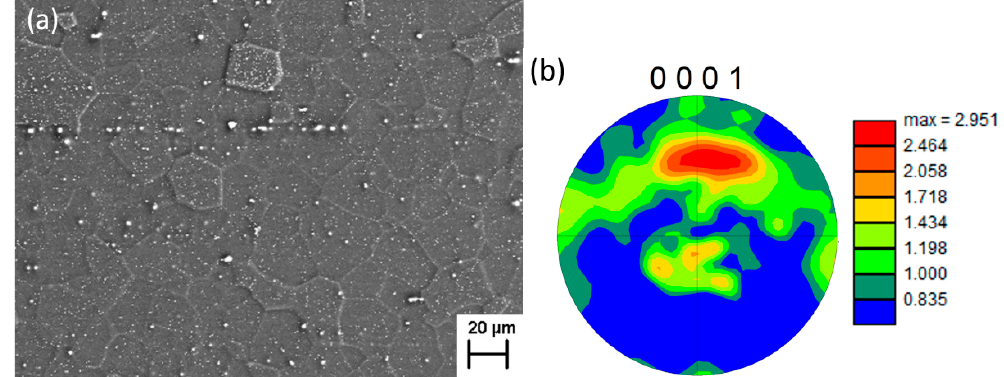
Figure 2. Microstructure at specimen surface along the extrusion direction ( a ) and (0001) Pole figure indicating a relatively randomized texture ( b ).